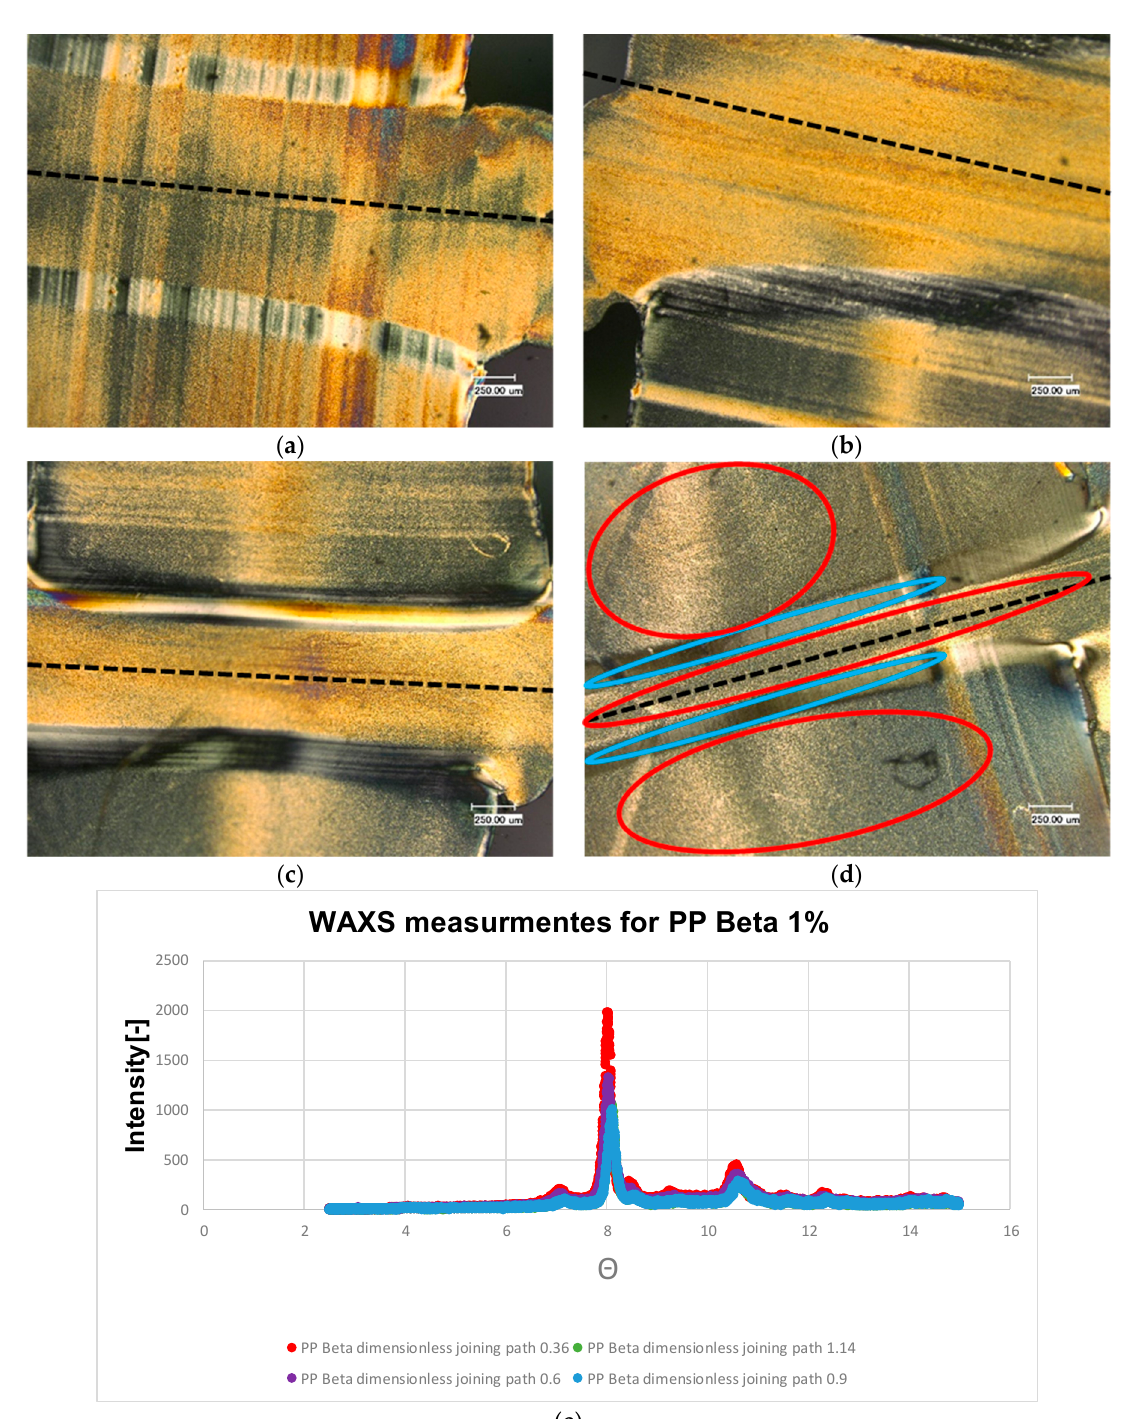
Figure 9. Microstructures of the welded PP beta 1 with dimensionless joining path ( a ): 0.3; ( b ): 0.5; ( c ): 0.75; ( d ): 0.95; ( e ): WAXS measurement results of the welded PP beta 1 for different joining paths. ● α -structure ● β -structure.